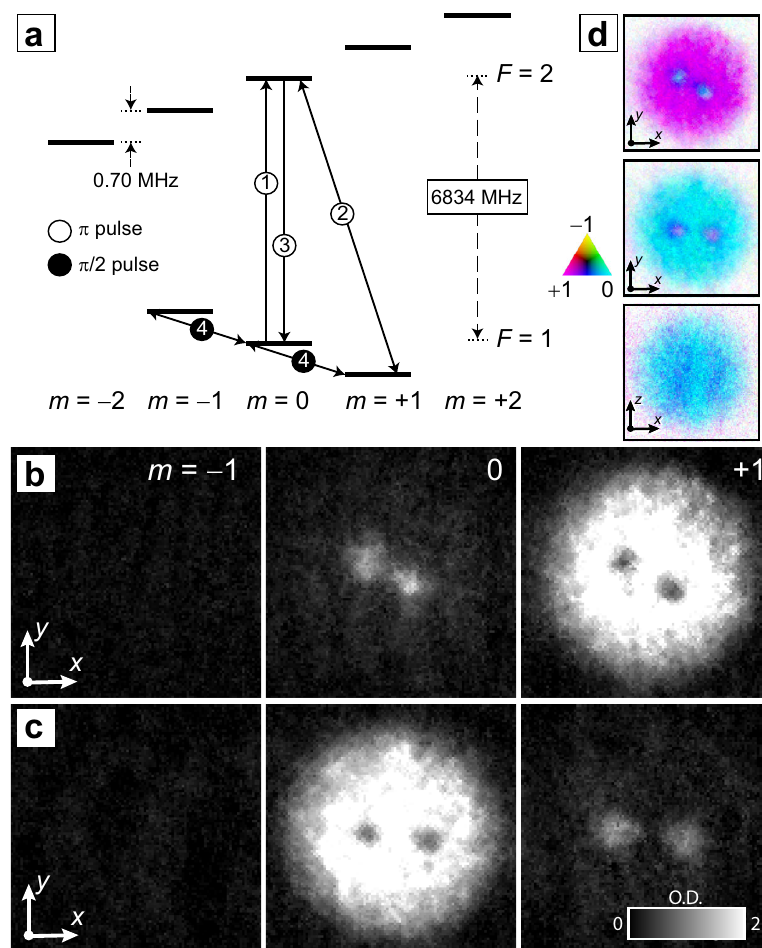
Fig. 1 Creation and detection of the polar singly-quantized vortices (SQVs). a A sequence of microwave π -pulses (open circles 1 – 3) swaps the m = + 1 and m = 0 spinor components via the F = 2, m = 0 state, taking the initial pair of SO(3) vortices ( b ) into a pair of polar SQVs with fi lled ferromagnetic cores ( c ). An optional radiofrequency π /2-pulse ( fi lled circle 4) rotates the spinor. The respective pulse lengths are (10, 82, 10, 15) μ s. b , c Images of the spinor- component column densities, integrated along the imaging ( z ) axis before ( b ) and after ( c ) the phase exchange sequence, in units of optical depth (O.D., grayscale bar). d False color spinor composition, with a top image of the ferromagnetic SQVs (upper) and top and side images of the polar SQVs (middle and bottom, respectively). Magenta and cyan correspond to pure m = + 1 and m = 0 spinor components, respectively. The fi eld of view in all panel images is 219 μ m × 219 μ